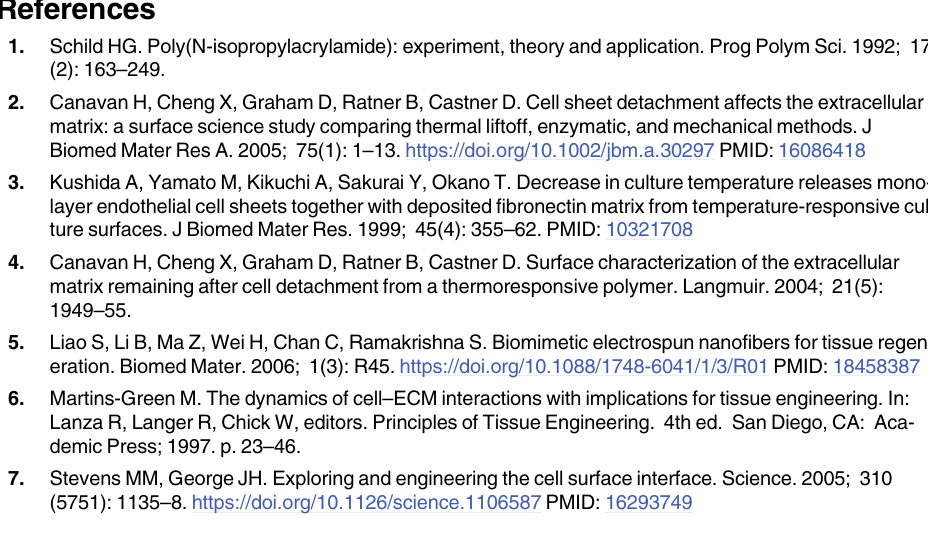
S1 Fig. FTIR spectra PNIPAM:OpePOSS:EMI fibers before and after curing. After curing, the epoxide peak at 910 cm -1 disappears, indicating that the crosslinking reaction occurred throughout the fiber